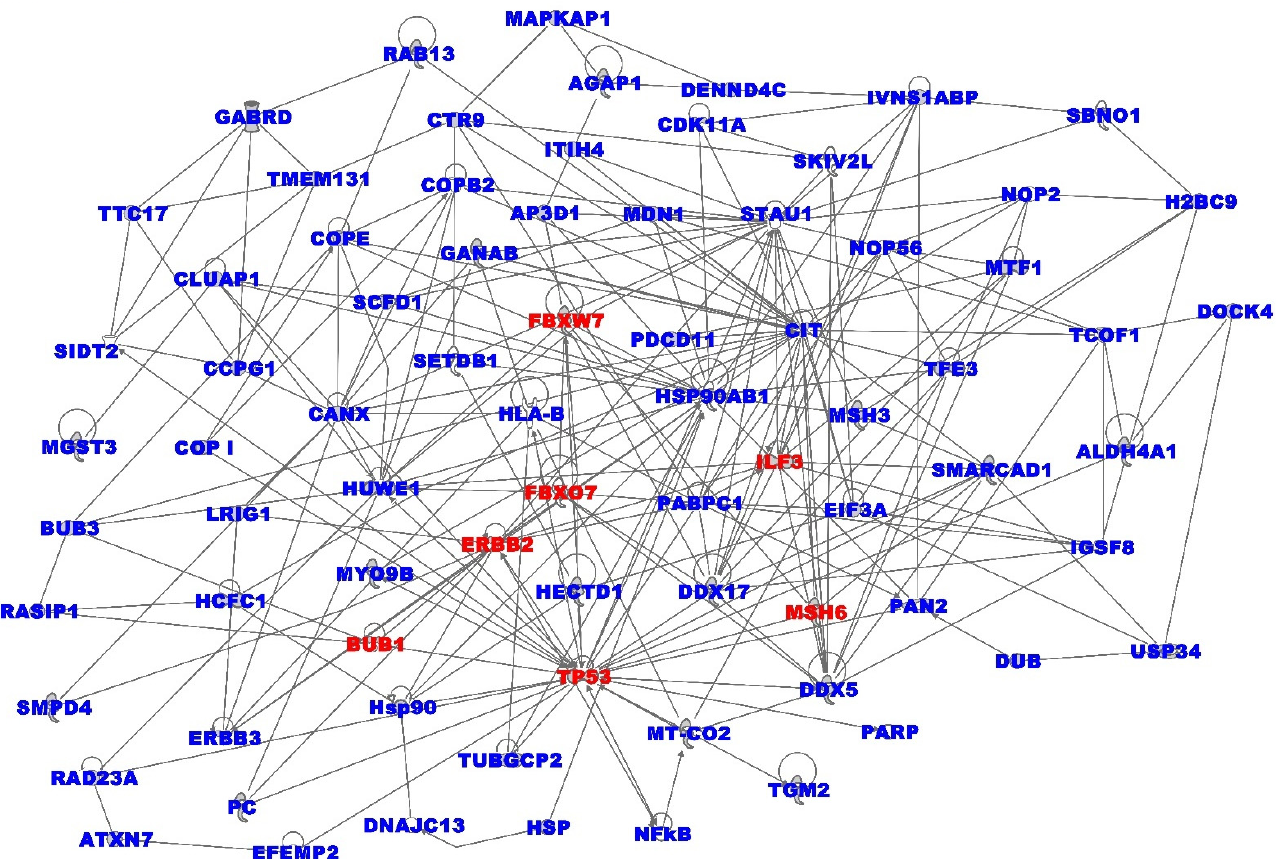
Figure 4. Molecular networks enriched for somatic mutations and immune-modulated genes in deceased patients diagnosed with TNBC. Genes in red fonts are somatic mutated immune-modulated genes associated with TNBC and genes in blue fonts are significantly DE and DM but not among the immune-modulated genes. Nodes represent genes, and vertices represent functional